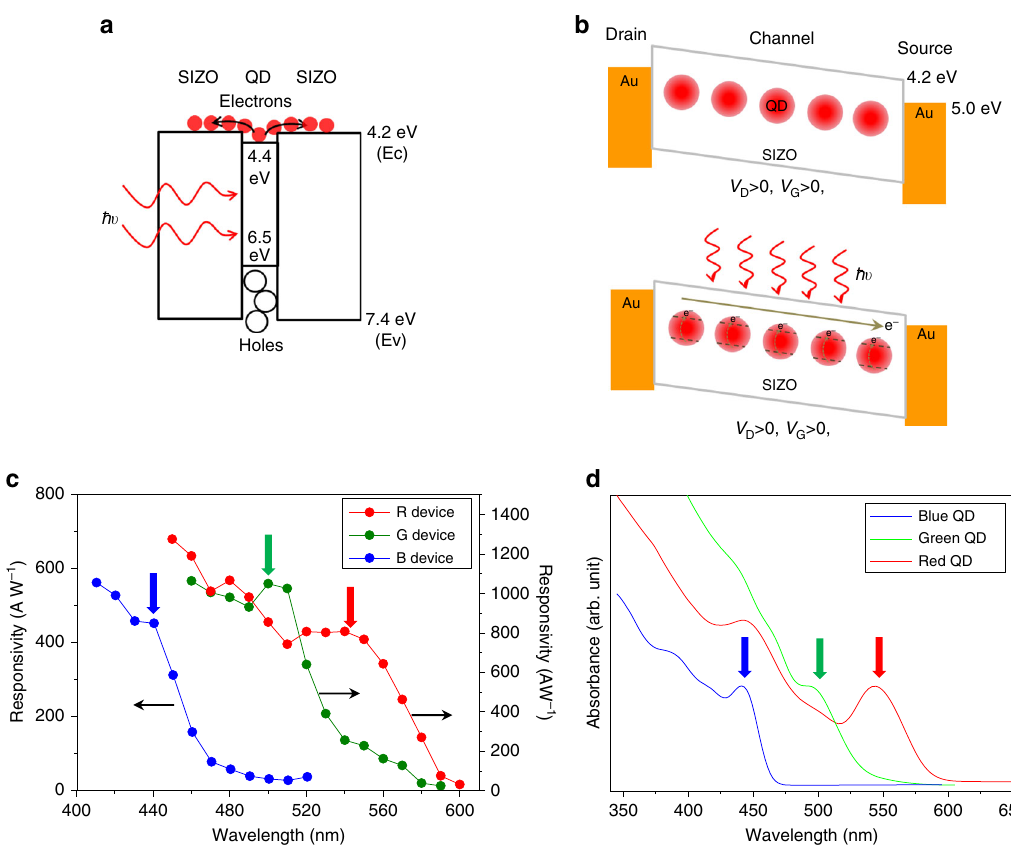
Fig. 2 Physical principles and spectral responses. a Energy diagram of red-QD OQO structure. b Light-induced carrier generation and transport mechanisms. c Spectral responses of 4RQ, 6GQ, and 6BQ OQO phototransistors. d Absorption spectra of red, green, and blue